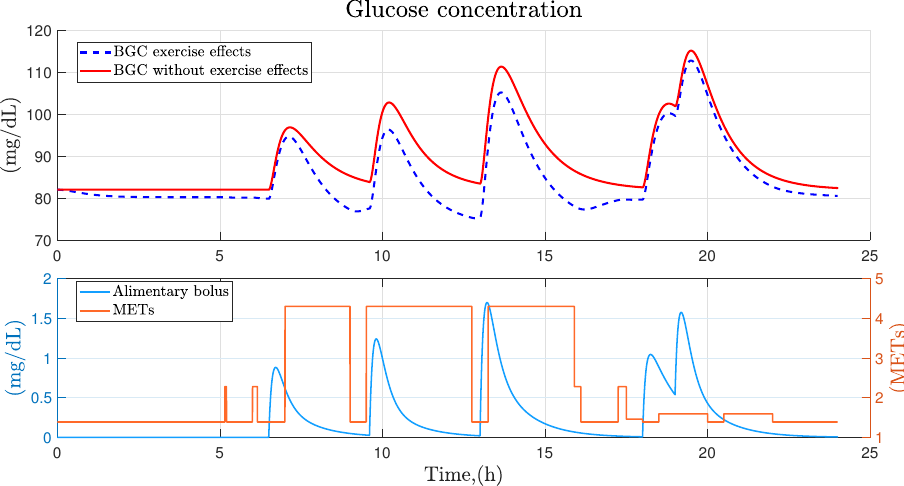
Figure 4. Effect of diet and physical activity on glucose concentration. Graphical visualization of the effect from diet and physical activity on the dynamics of blood glucose